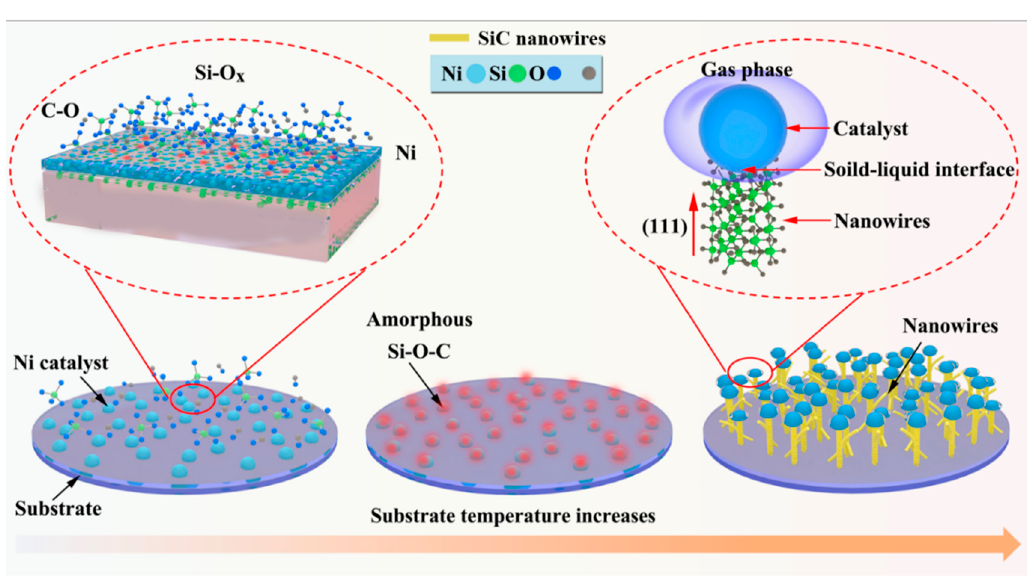
Figure 7. Schematic diagram of growth mechanisms of SiC nanowires loaded with Ni catalysts.